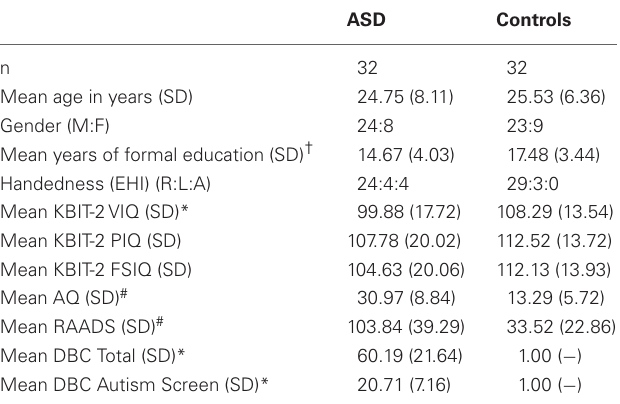
Table 1 | Participant demographics.